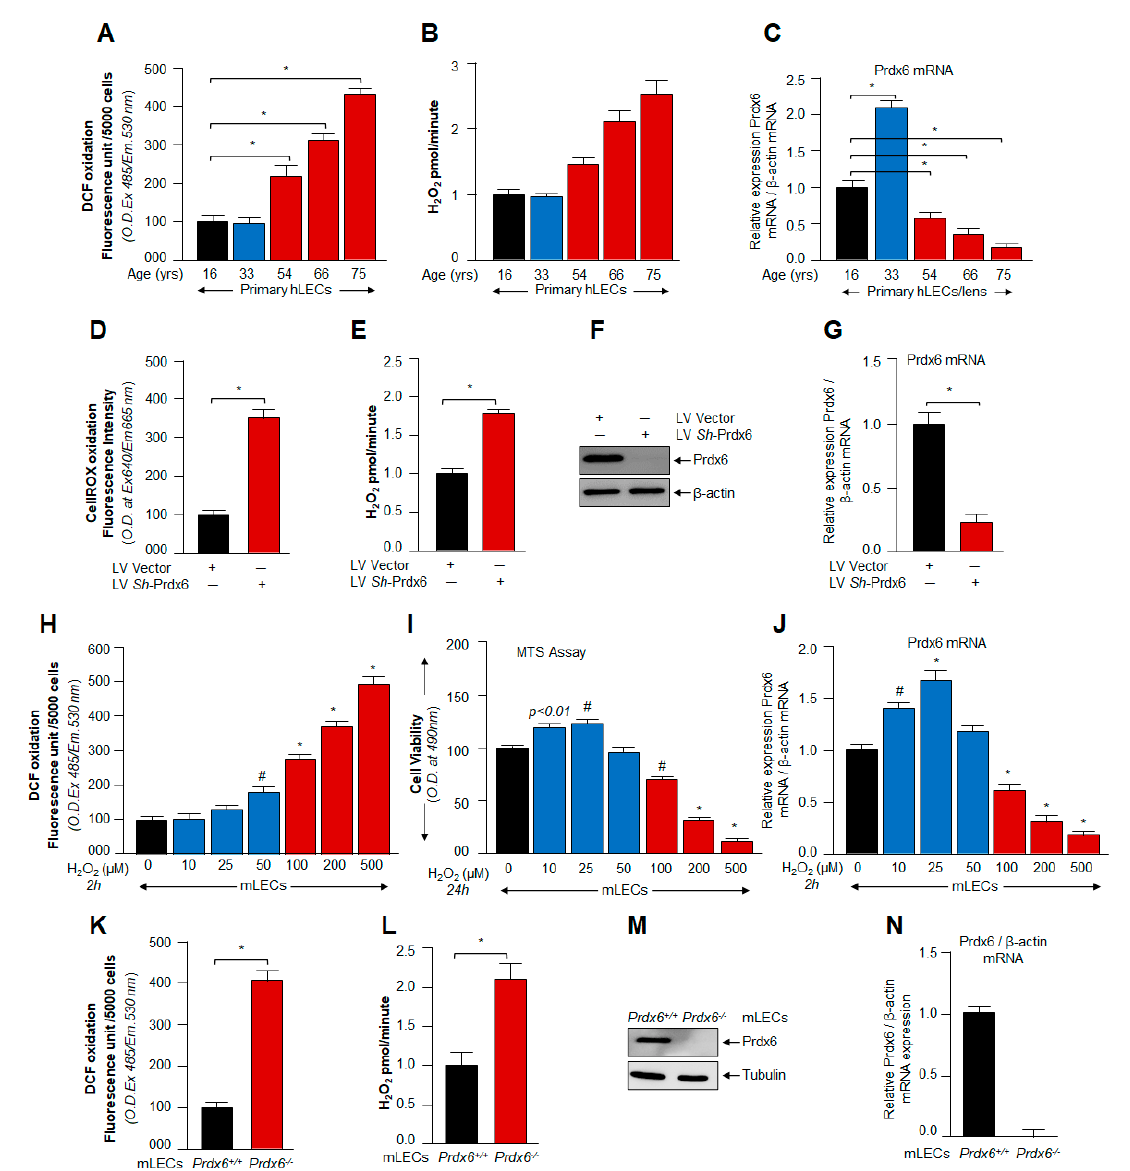
Figure 1. LECs displayed increased ROS levels, H 2 O 2 generation and reduced level of Prdx6 with advancing age. ( A – C ) Increased ROS-induced DCF toxicity and H 2 O 2 generation with loss of Prdx6 expression was observed in human LECs with aging. ( A ) Intracellular ROS were quantified in primary hLECs of different ages using H2-DCF-DA dye. The data represent the mean ± S.D. from three independent experiments (* p < 0.001). ( B ) H 2 O 2 levels in primary hLECs were measured using Amplex Red reagent and Horseradish Peroxidase (HRP) solution. The data represent the mean ± S.D. from three independent experiments (* p < 0.001). ( C ) Total RNA was extracted from LECs isolated from lenses of human individuals of variable age groups and transcribed cDNA was submitted to real time PCR analysis with primers specific to Prdx6. The data represent the mean ± S.D. from three independent experiments (* p < 0.001). ( D – G ) Prdx6- depleted hLECs displayed increased ROS- induced DCF toxicity levels and production of H 2 O 2 in cells. hLECs were stably infected with GFP (green fluorescence protein) linked lentiviral (LV)-vector or GFP- linked LV Sh -Prdx6 as noted in Ma- terials and Methods. ( D , E ) Stably infected hLECs with LV-Vector or LV Sh -Prdx6 was harvested in 96 well plate. ROS-induced CellROX toxicity ( D ) and H 2 O 2 generation ( E ) in cells were quantified using CellROX Red reagent dye assay and Amplex Red reagent/Horseradish Peroxidase (HRP) solution, respectively. The data represent the mean ± S.D. from three independent